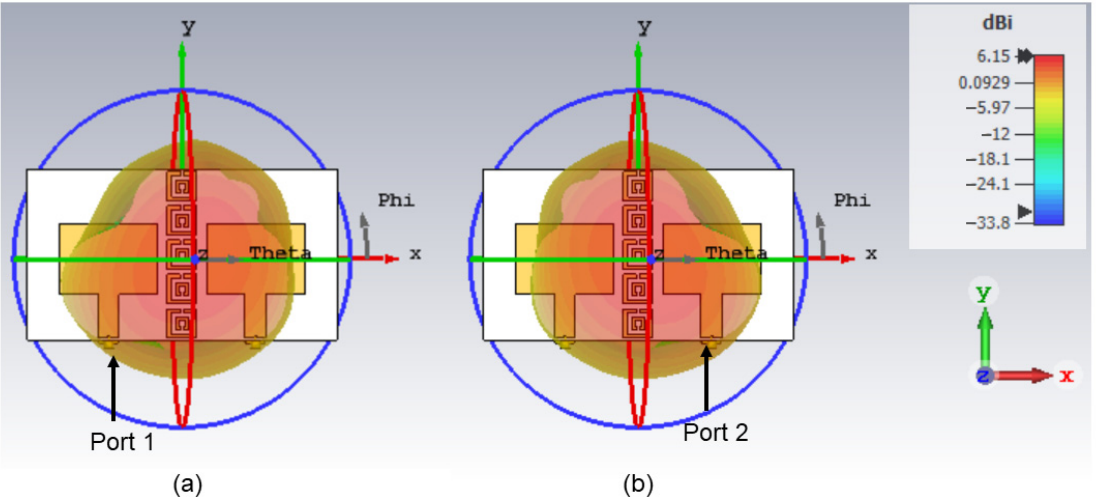
Figure 13. The 3D radiation pattern results of MIMO-RIS-EBG ( a ) antenna 1 and ( b ) antenna 2.